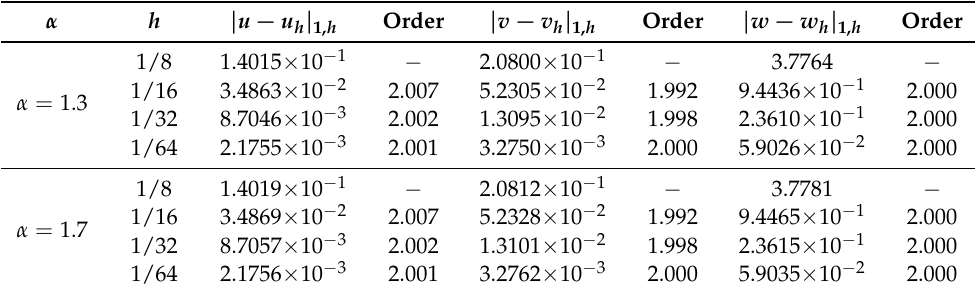
Table 4. H 1 -harf-norm errors and spatial convergence order of MFVE method.